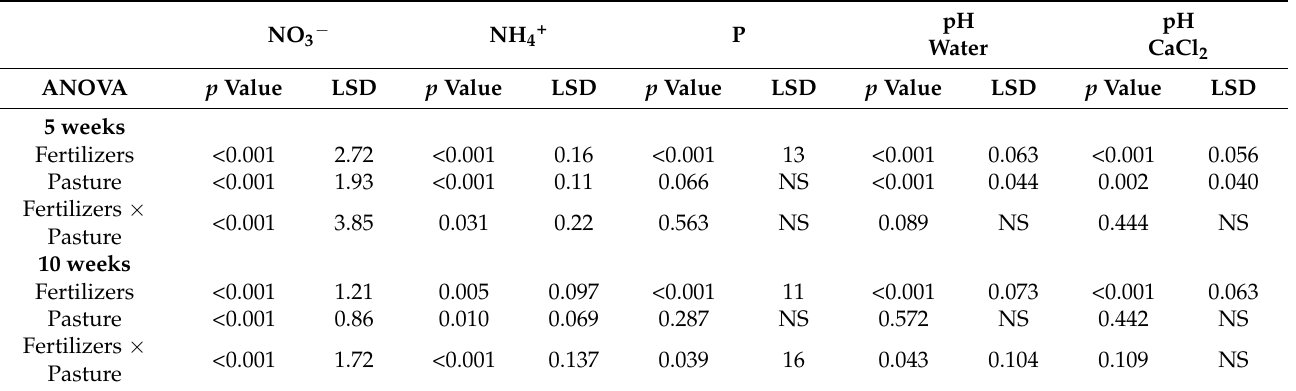
Table 3. ANOVA for available nitrate, ammonium and extractable Colwell P and soil pH (water and CaCl 2 ) for subterranean clover and annual ryegrass after 5 and 10 weeks after sowing. LSD value given if p ≤ 0.05. NS = not